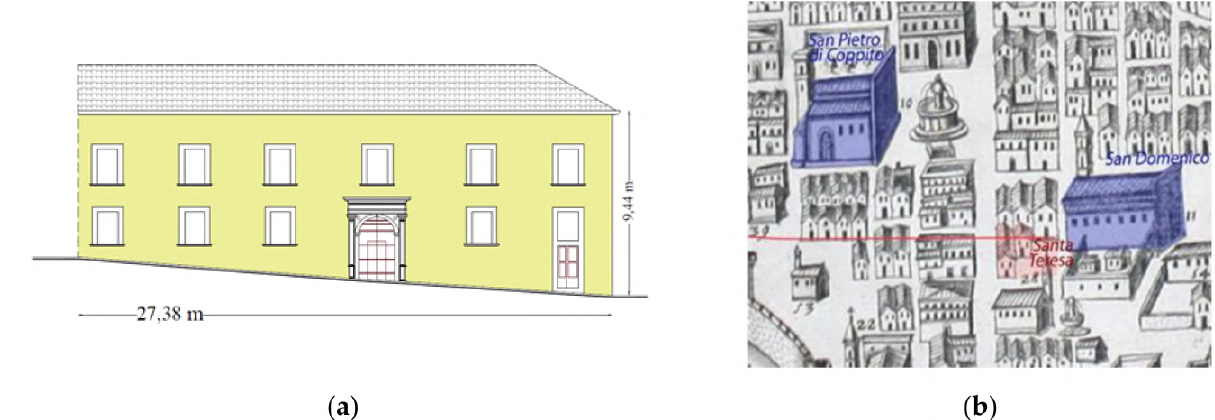
Figure 3. ( a ) Prospect of the St. Teresa convent; ( b ) historical map with the indication of the position of the St. Teresa convent [26]. The palaces built and rebuilt between the 16th and 18th century in the city’s historical center highlight recurrent constructive features and less scattered mechanical properties.